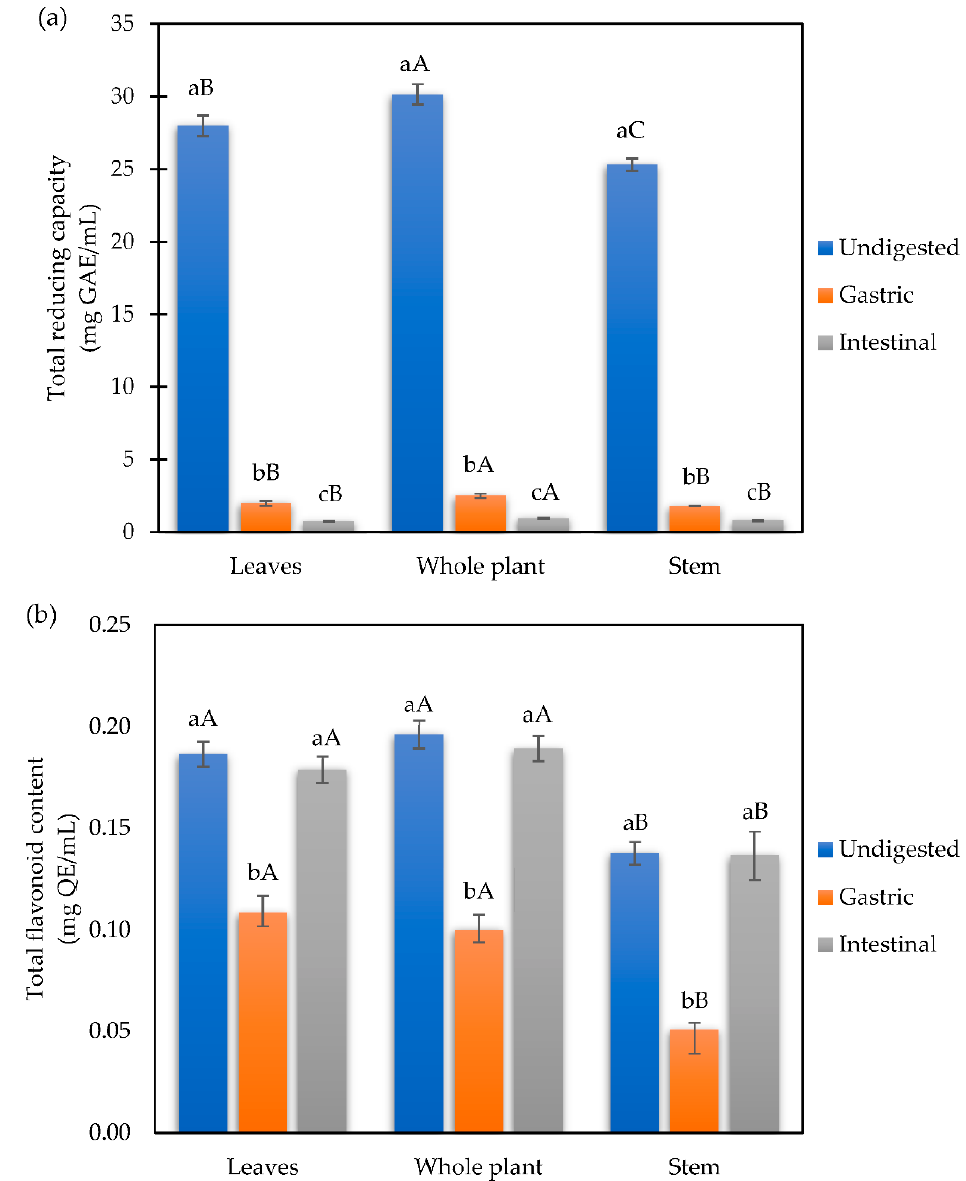
Figure 2. ( a ) Total reducing capacity and ( b ) total flavonoid content of mistletoe infusions subjected to simulated in vitro gastrointestinal digestion. Different letters indicate statistical significance ( p < 0.01) by Tukey’s test. Data shown as means ± SD of three replicates (n = 3). Means that do not share capital letters show statistical differences between plant parts in each digestive phase by the Tukey test ( p < 0.05).